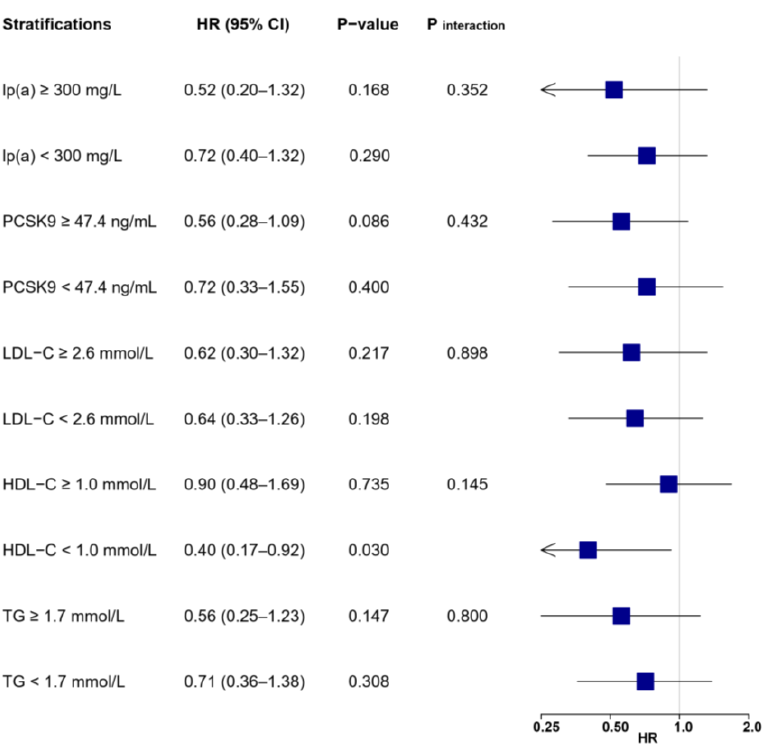
Figure 8. Associations between LL-37 and the risk of recurrent MI according to lipid profile values. Multivariable Cox regression was adjusted for variables with p < 0.1 in univariable analysis (see Supplementary Table S5), including age, previous MI, systolic blood pressure, creatinine, N-terminal prohormone of brain natriuretic peptide, LDL-C, and successful revascularization. HDL-C = high-density lipoprotein cholesterol; LDL-C = low-density lipoprotein cholesterol; lp(a) = lipoprotein(a); MI = myocardial infarction; PCSK9 = proprotein convertase subtilisin/kexin type 9; TG = triglyceride.